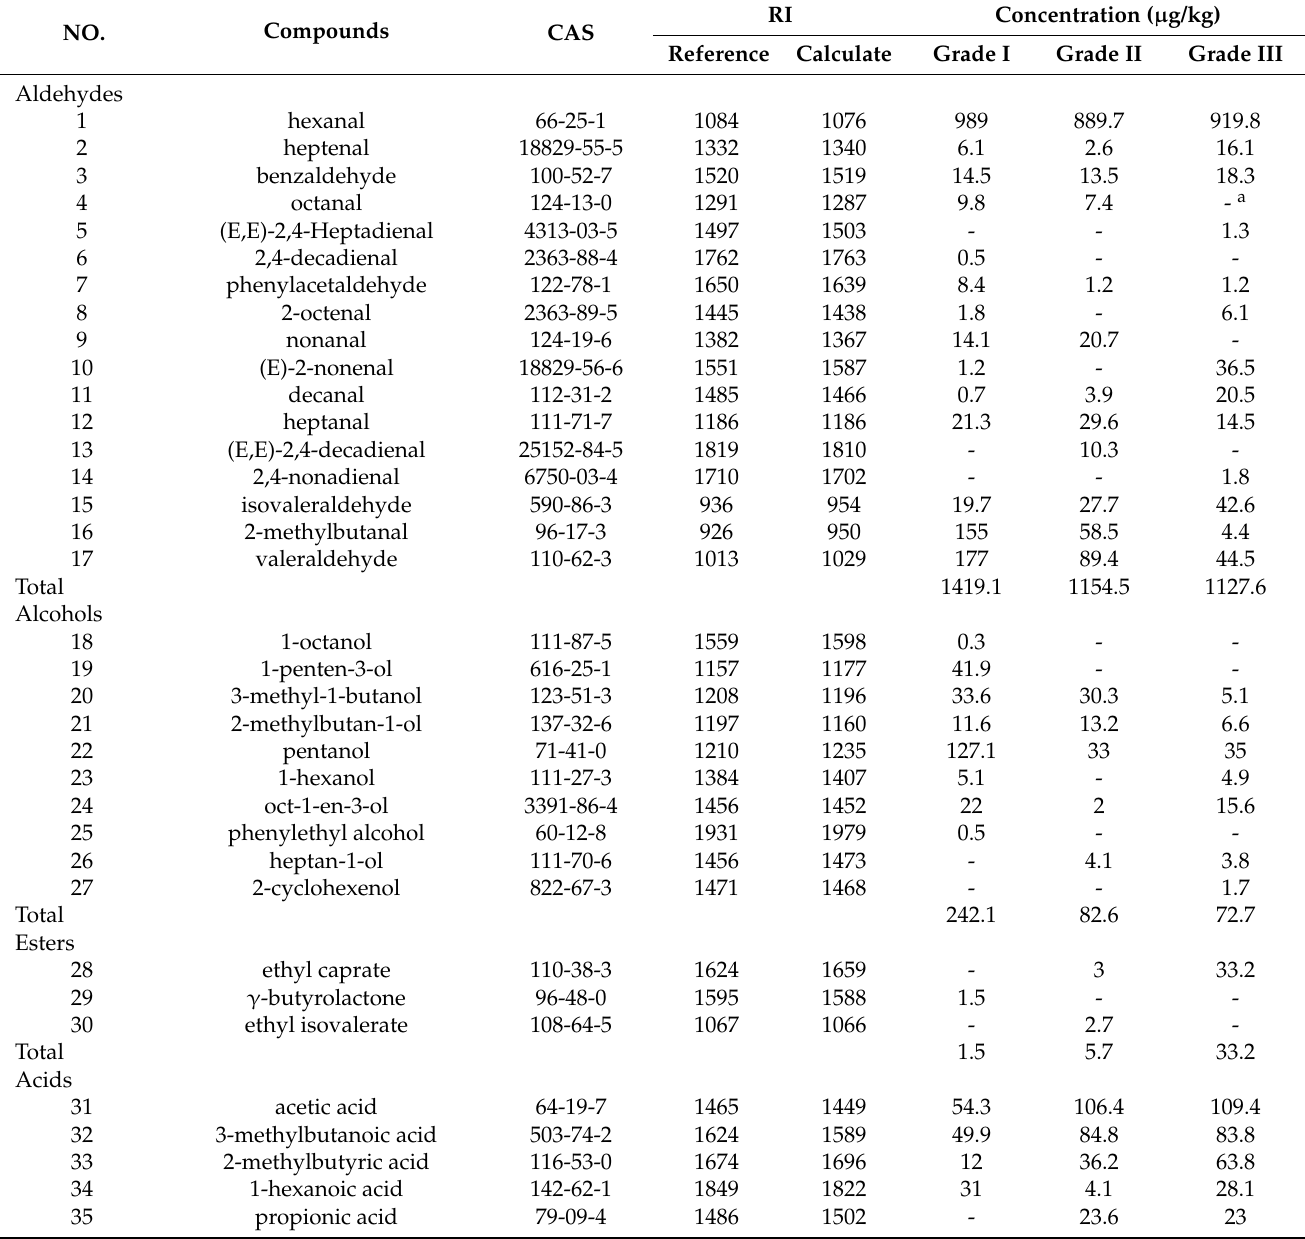
Table 1. Analysis results of flavor volatiles of Jinhua ham from Grades I to